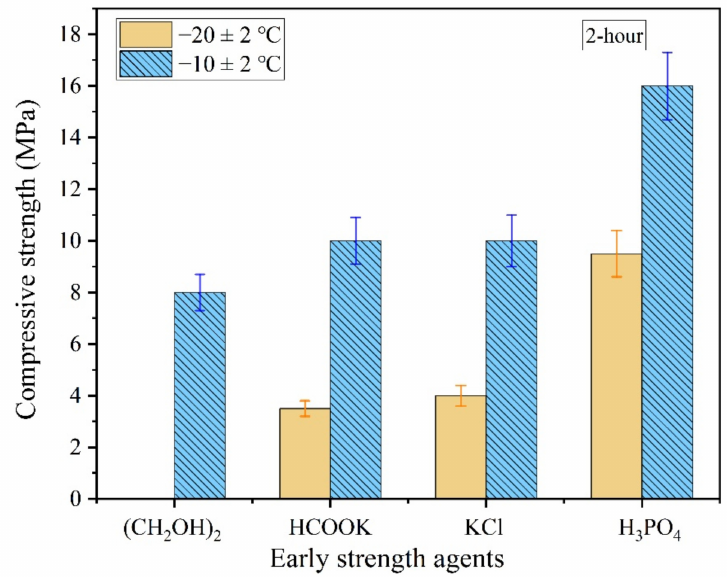
Figure 2. The 2 h compressive strength of the magnesium phosphate cement (MPC) with early strength agents in severe cold